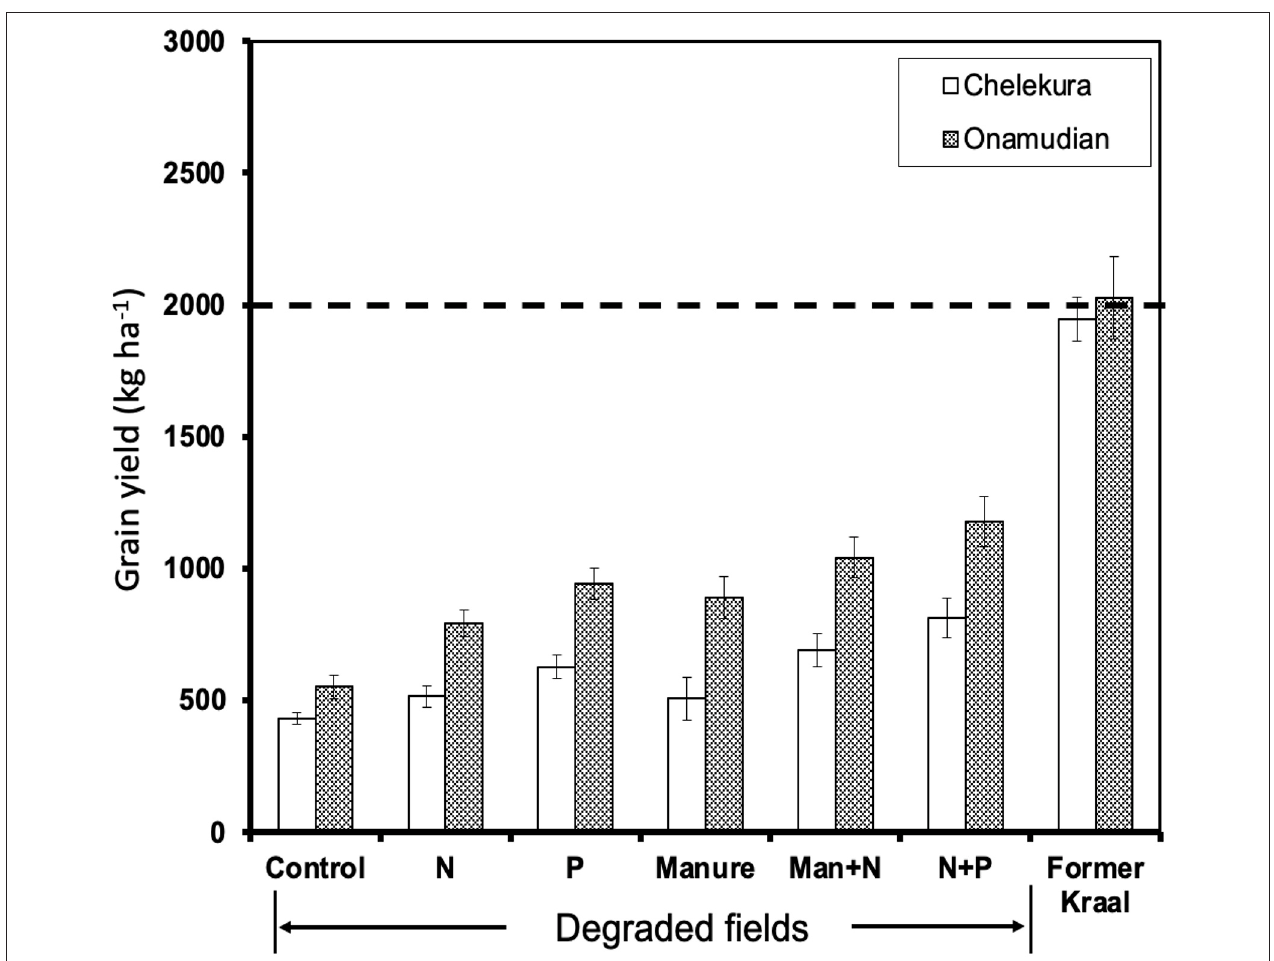
FIGURE 4 | Average responses of finger millet grain yields per applied treatment on degraded fields in comparison with the former kraal sites in the study villages, 2006. Bars are SEM.